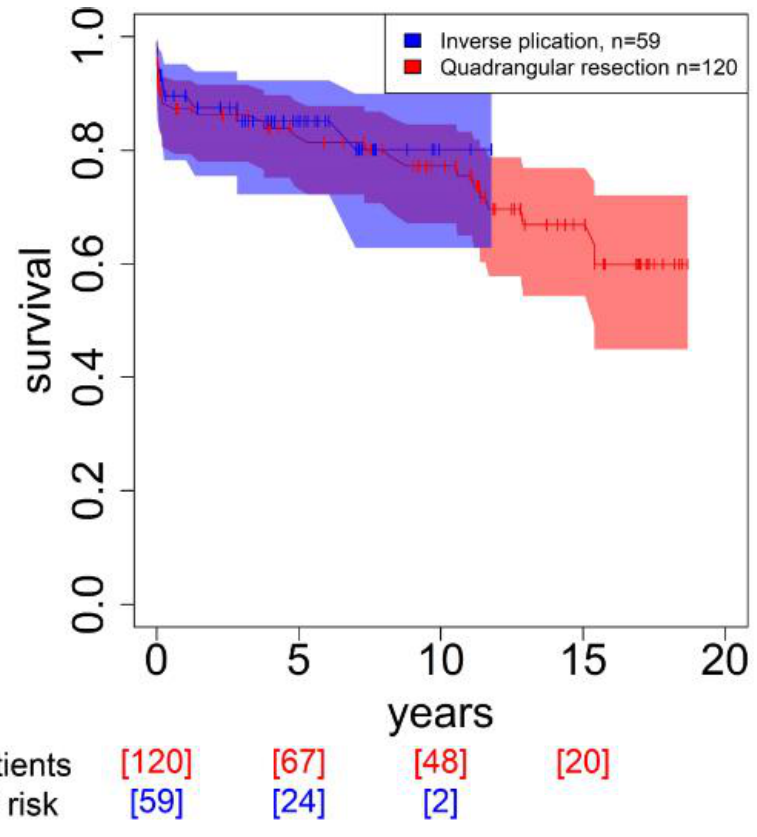
Figure 3. Kaplan – Meier survival curve. Figure 3. Kaplan–Meier survival